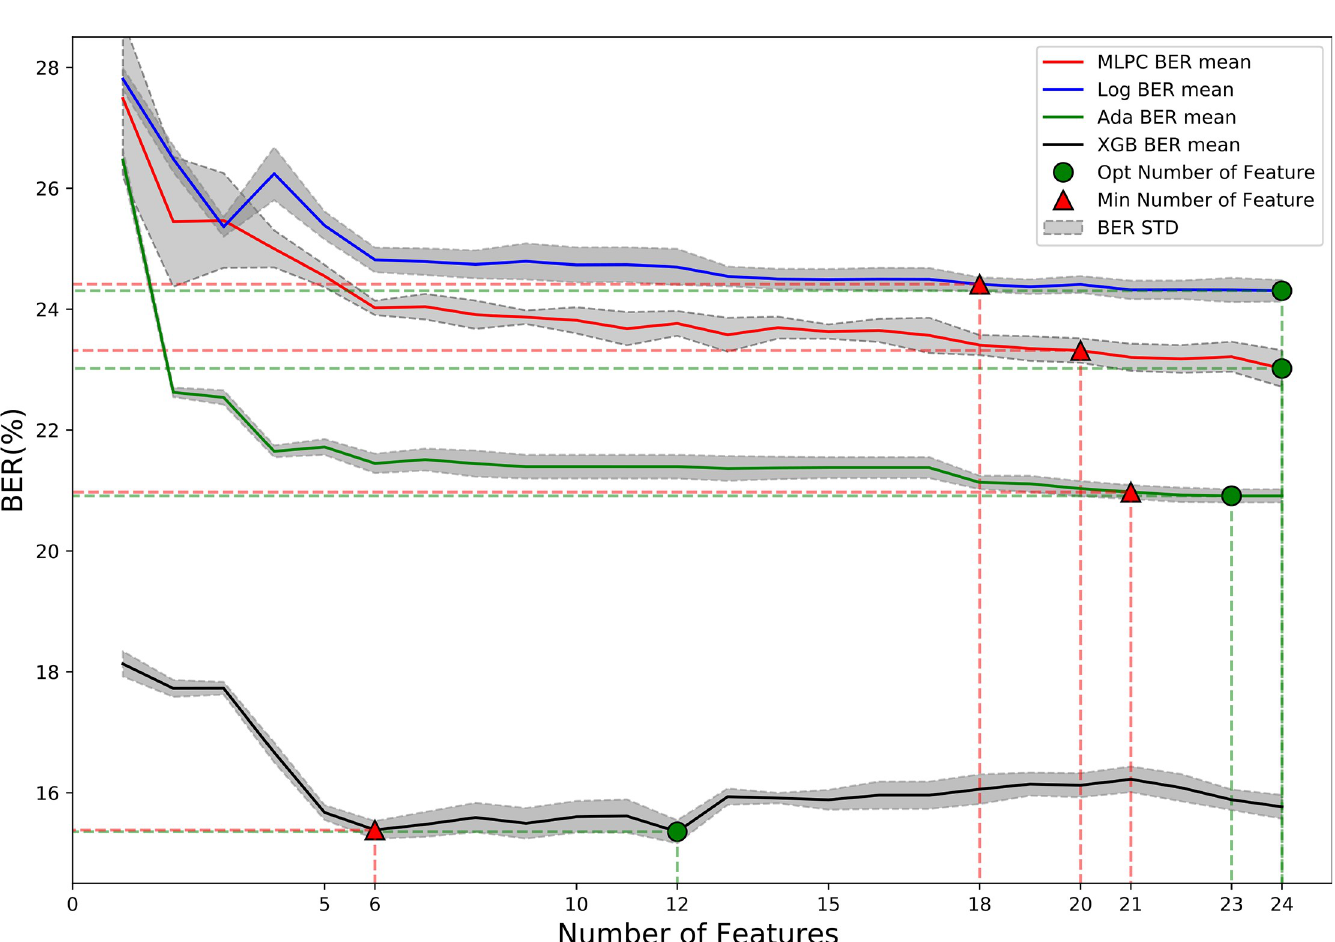
Fig 4. Feature selection based on the four methods discussed in this study. The X-axis is the feature number, the y-axis is the BER average of the ten-fold cross- validation, and the gray shaded area is the BER standard deviation of the ten-fold cross-validation under a specific feature subset. The figure shows the trend of BER changes of the four algorithms in the process of adding features step by step. The position of the green circle is the optimal feature subset of the algorithm, and the red triangle is the smallest feature